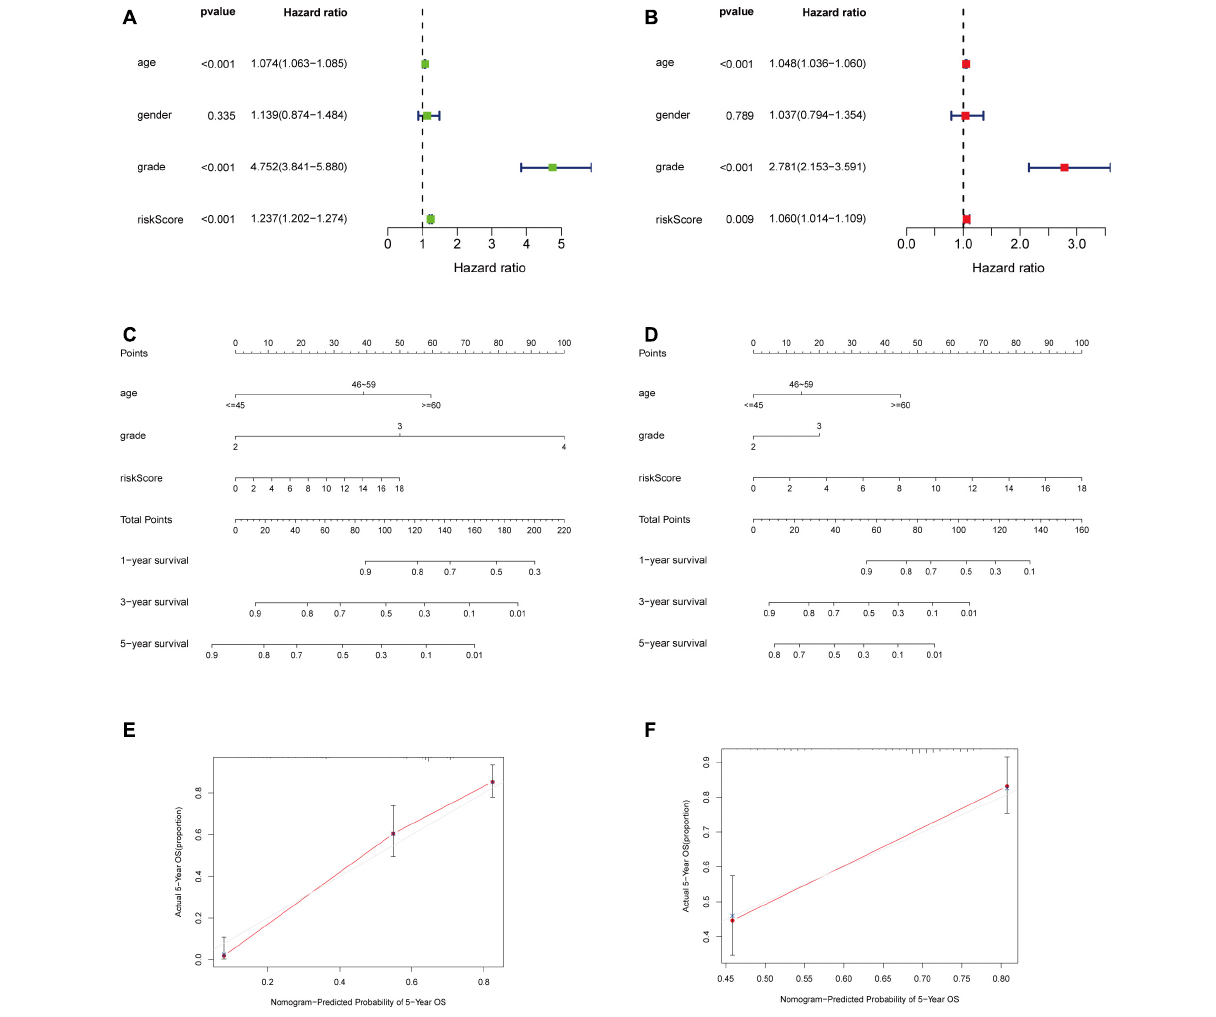
FIGURE 5 | Independent prognostic analysis of the immune-related lncRNA prognostic signature. The univariate (A) and multivariate (B) Cox regression analysis of risk score, age, gender, and grade. A nomogram to quantitatively predict 1-, 3-, and 5-year survival for all the glioma patients (C) and non–glioblastoma multiforme patients (D) Calibration curves of the nomogram model for showing the consistency between predicted and actual survival in all the glioma patients (E) and non–glioblastoma multiforme patients (F)